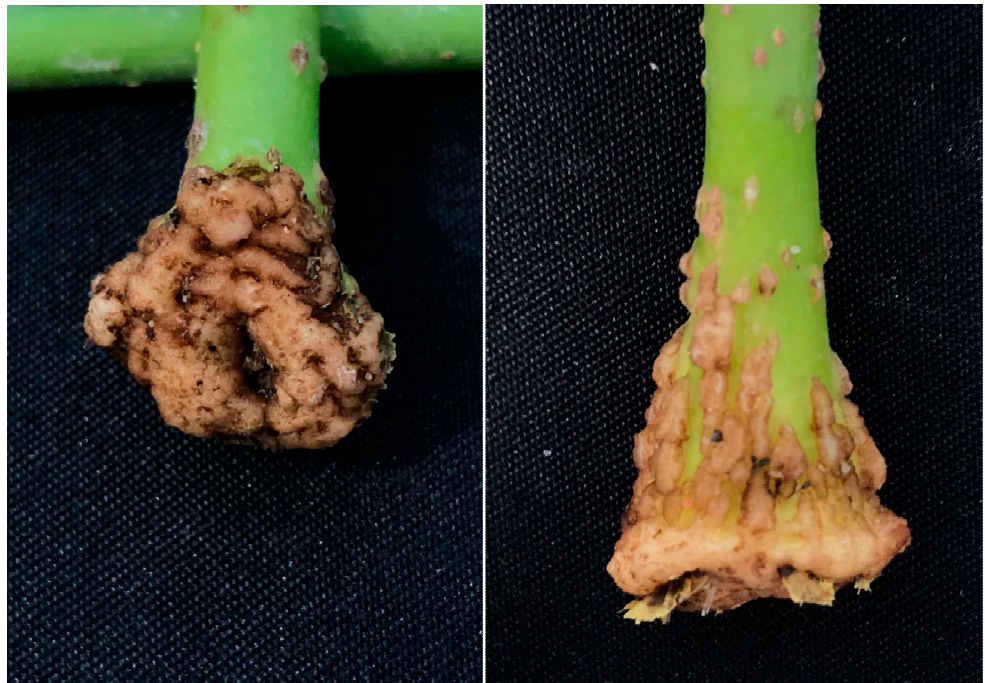
Figure A1. At 13 days after planting, cuttings in Control formed some white callus tissues on the epidermis.